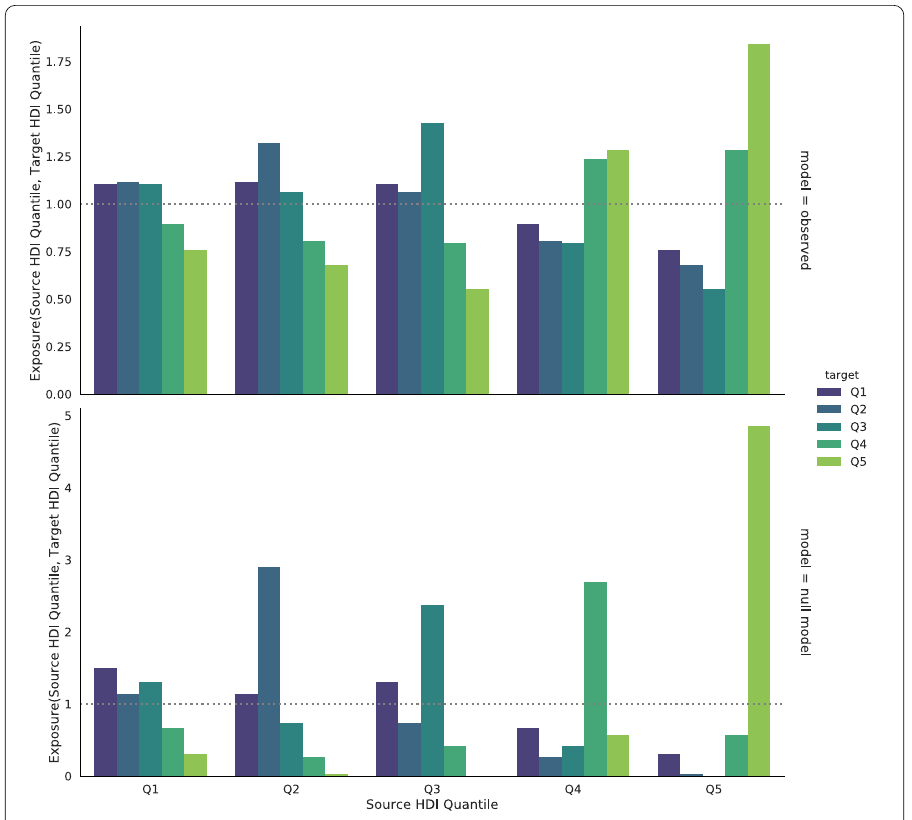
Figure 7 Results of the social mixing index, using the segregation model [11], for the observed mall visits (top) and for a null model where users visit their nearest mall (bottom). Each bar shows the value of social mixing E for two categories of HDI. A value of E > 1 implies social mixing, while a value of E < 1 implies social exclusion. All E values are significant in this figure. Error bars are negligible with respect to height, and thus, have not been included in the